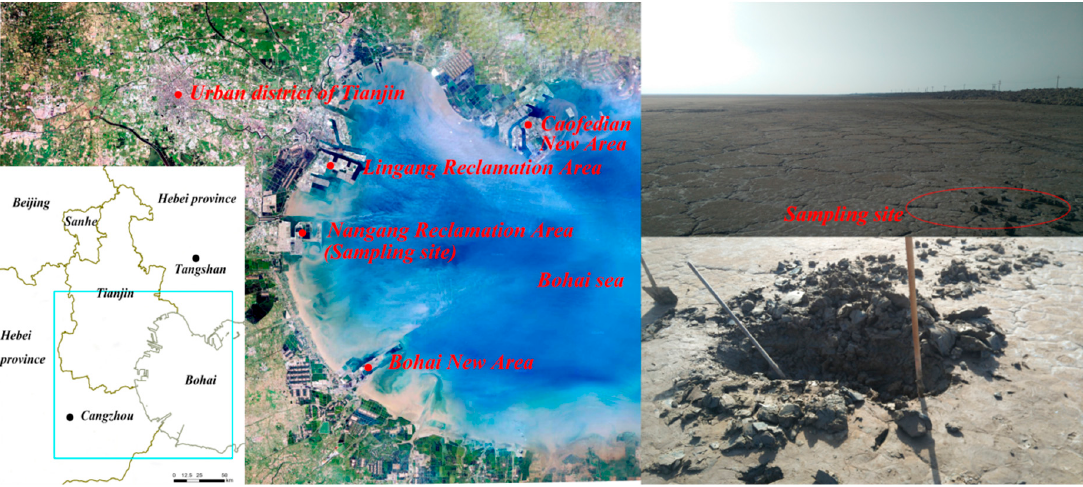
Figure 1. Sampling sites of the soft soil used in this study.